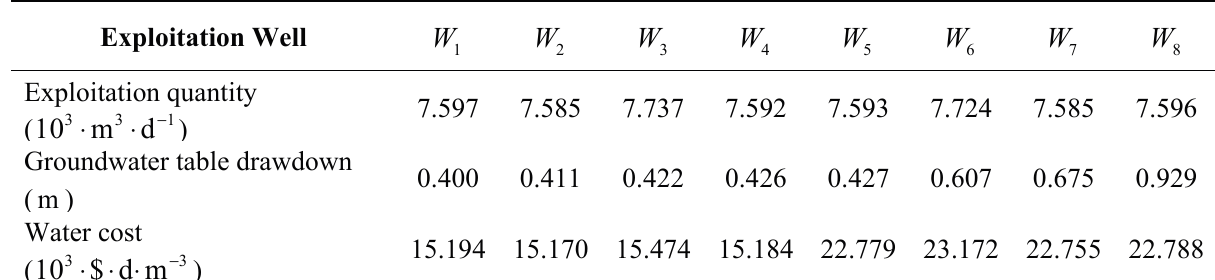
Table 6. The optimal exploitation